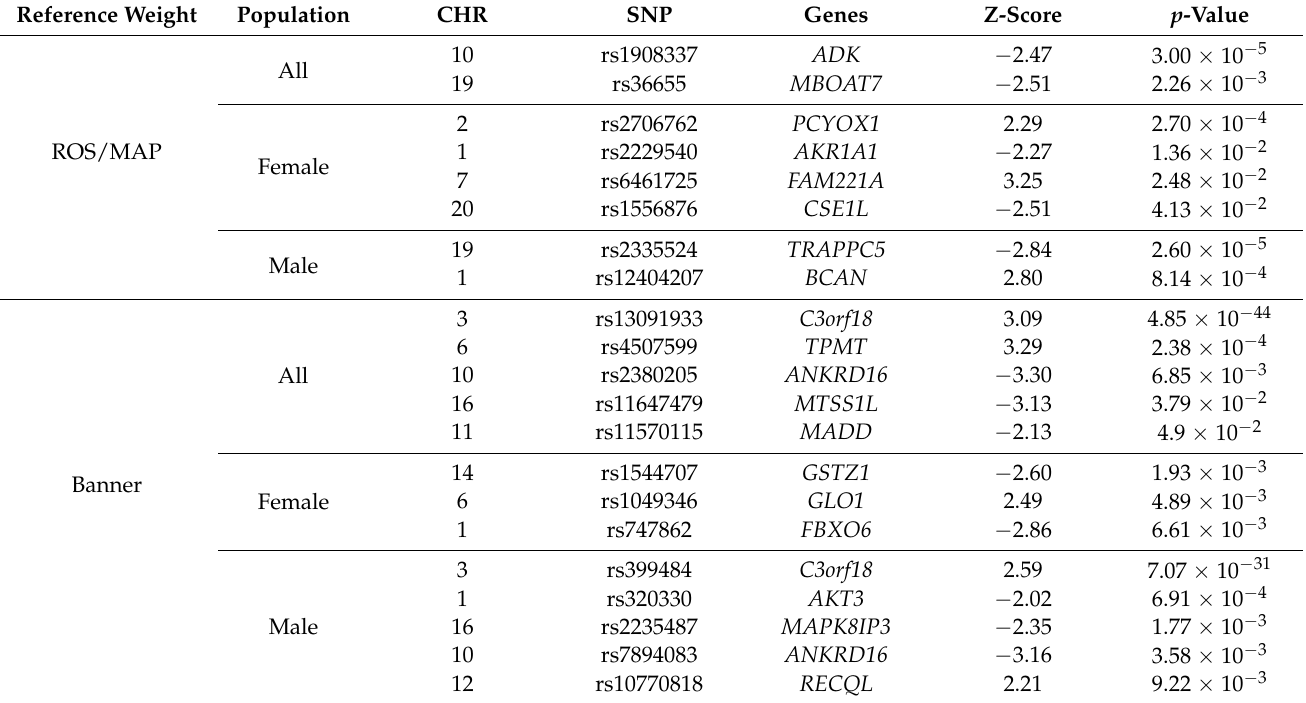
Table 1. Proteome-wide association study (PWAS) results for